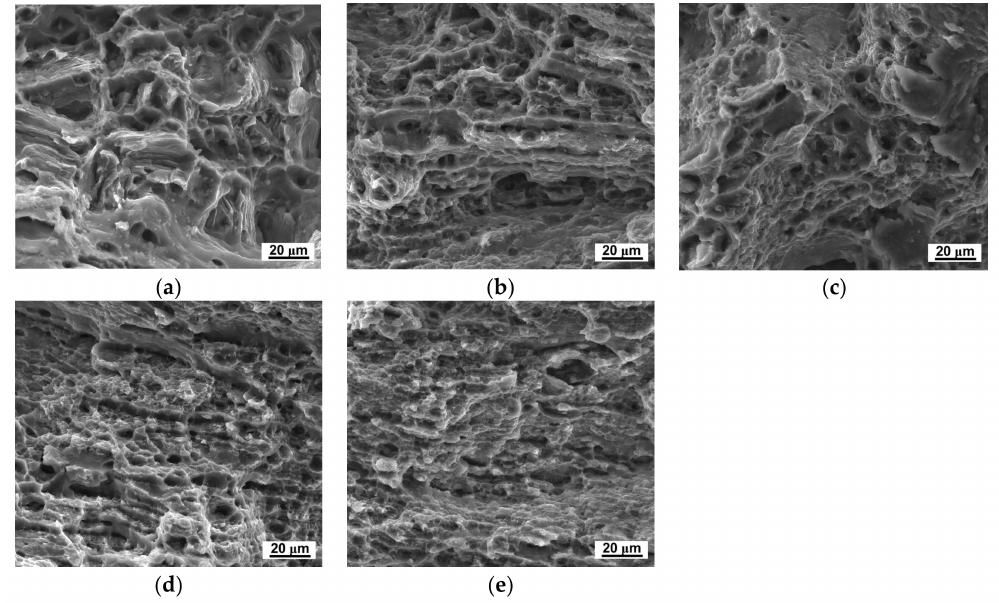
Figure 8. Micro-tensile fracture morphology of the LZ91 alloy ( a ) Before and after HPT processing through ( b ) 1/4; ( c ) 1; ( d ) 5, and ( e ) 10